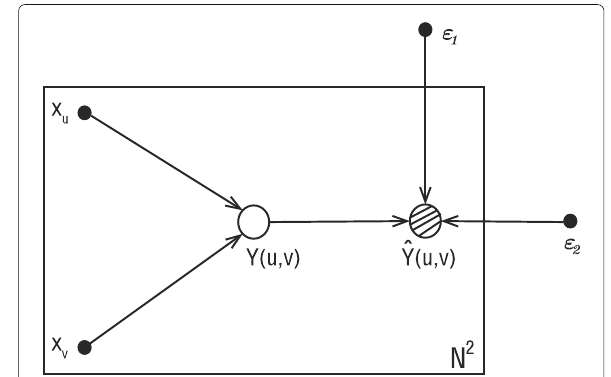
Fig. 2 Graphical illustration of the proposed game-theoretic generative model